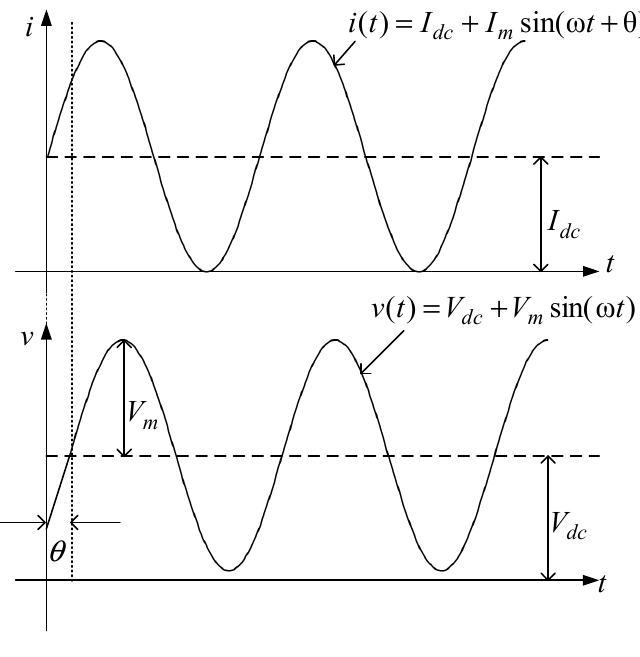
Figure 7. The charge current and battery voltage waveforms containing DC components.